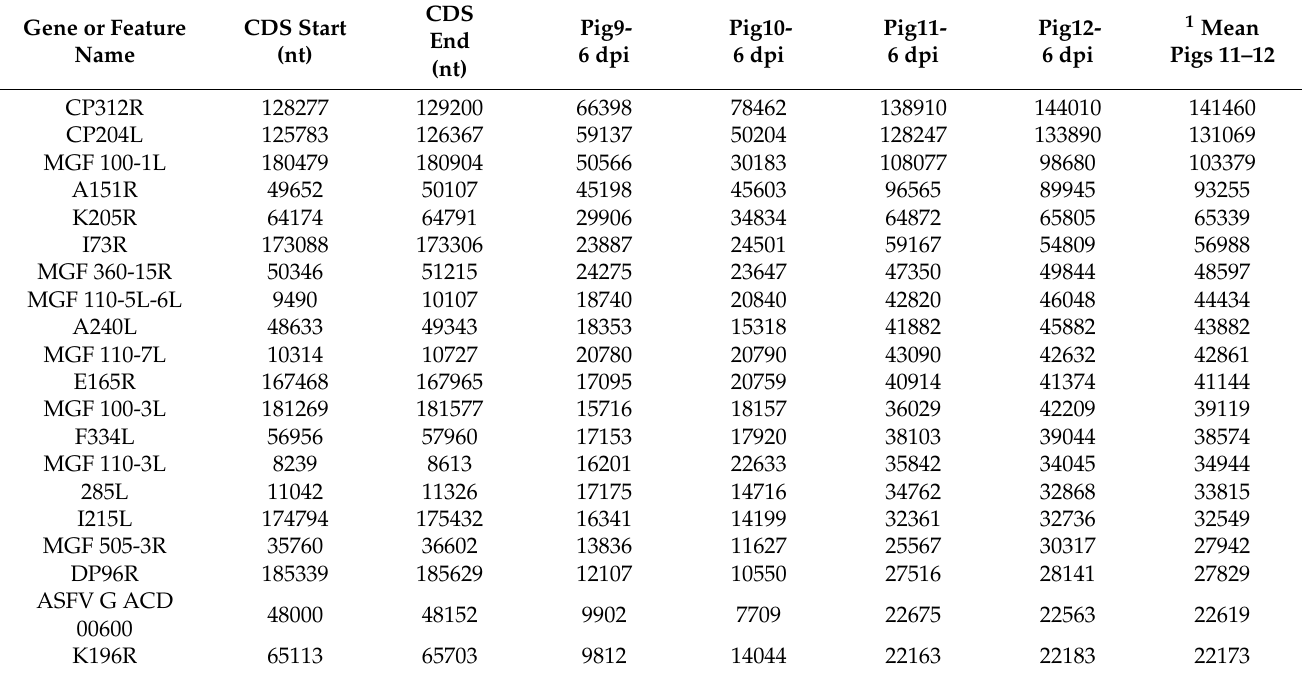
Table 3. Total numbers of reads for annotated ASFV genome features that are highly expressed in PBMCs from infected pigs at 6